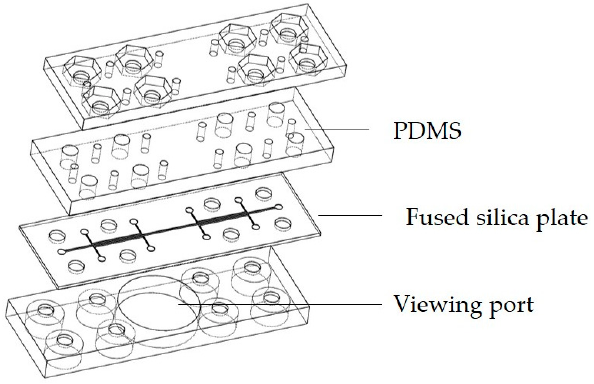
Figure 1. Illustration of the layered microfluidic device. Top and bottom plates were 3D printed with holes to accommodate #8-32 screws. The bottom plate is equipped with a viewing port for an inverted microscope. The second layer from the top is made of PDMS. The second plate from the bottom is the fused silica microfluidic plate.